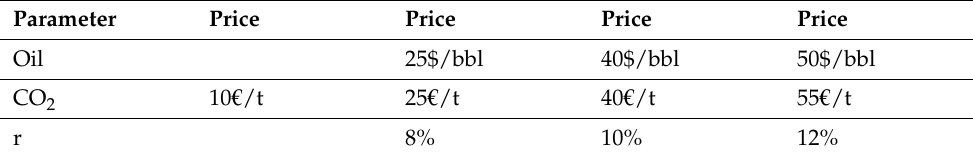
Table 4. Input values for oil, carbon prices, and discount rate (r).